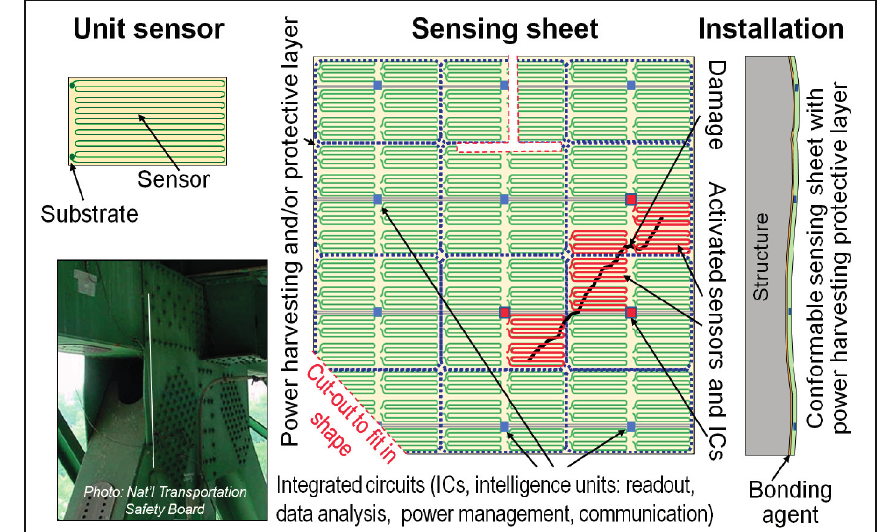
Figure 2. Schematic representation of the sensing sheet based on LAE and ICs, with permission from